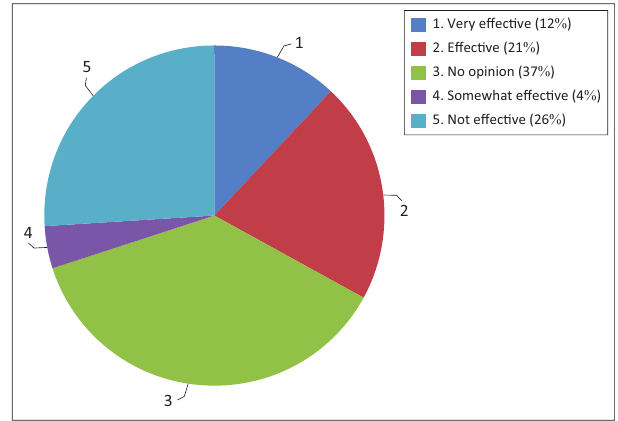
FIGURE 2: Participants’ opinions of succession plans for knowledge transfer ( n = 112).